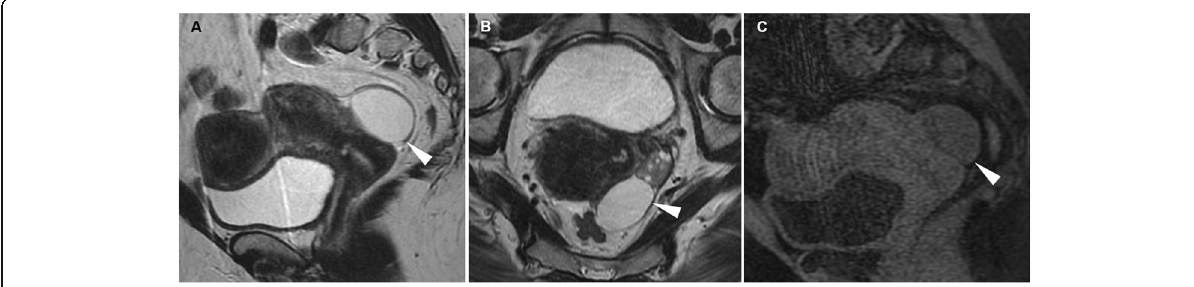
Fig. 5 MRI of a functional cyst causing pelvic pain in the periovulatory phase in a 37-year-old woman. Sagittal ( a ) and oblique-axial ( b ) T2- weighted images show a 4-cm well-marginated, unilocular cystic lesion with thin walls and homogeneous fluid-like signal intensity arising from the posterior edge of the left ovary (arrowheads), without haemorrhagic hyperintensity on sagittal precontrast fat-suppressed T1-weighted image ( c